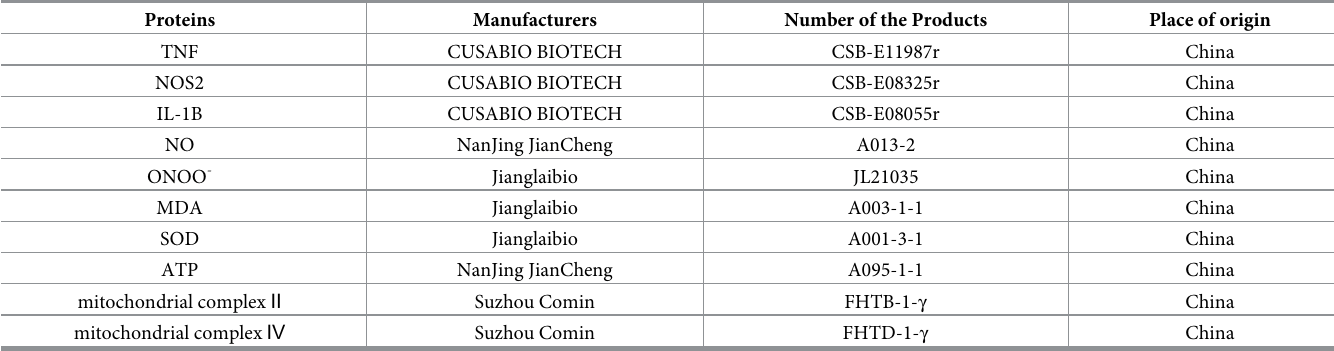
Table 1. Details of the ELISA